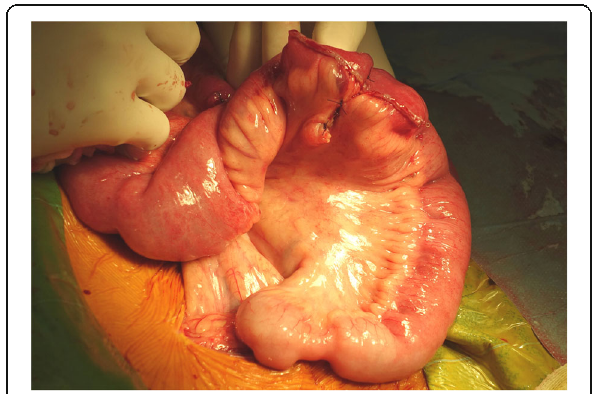
Fig. 2 Intraoperative view: side-to-side intestinal anastomosis with GIA stapler and distal intestinal